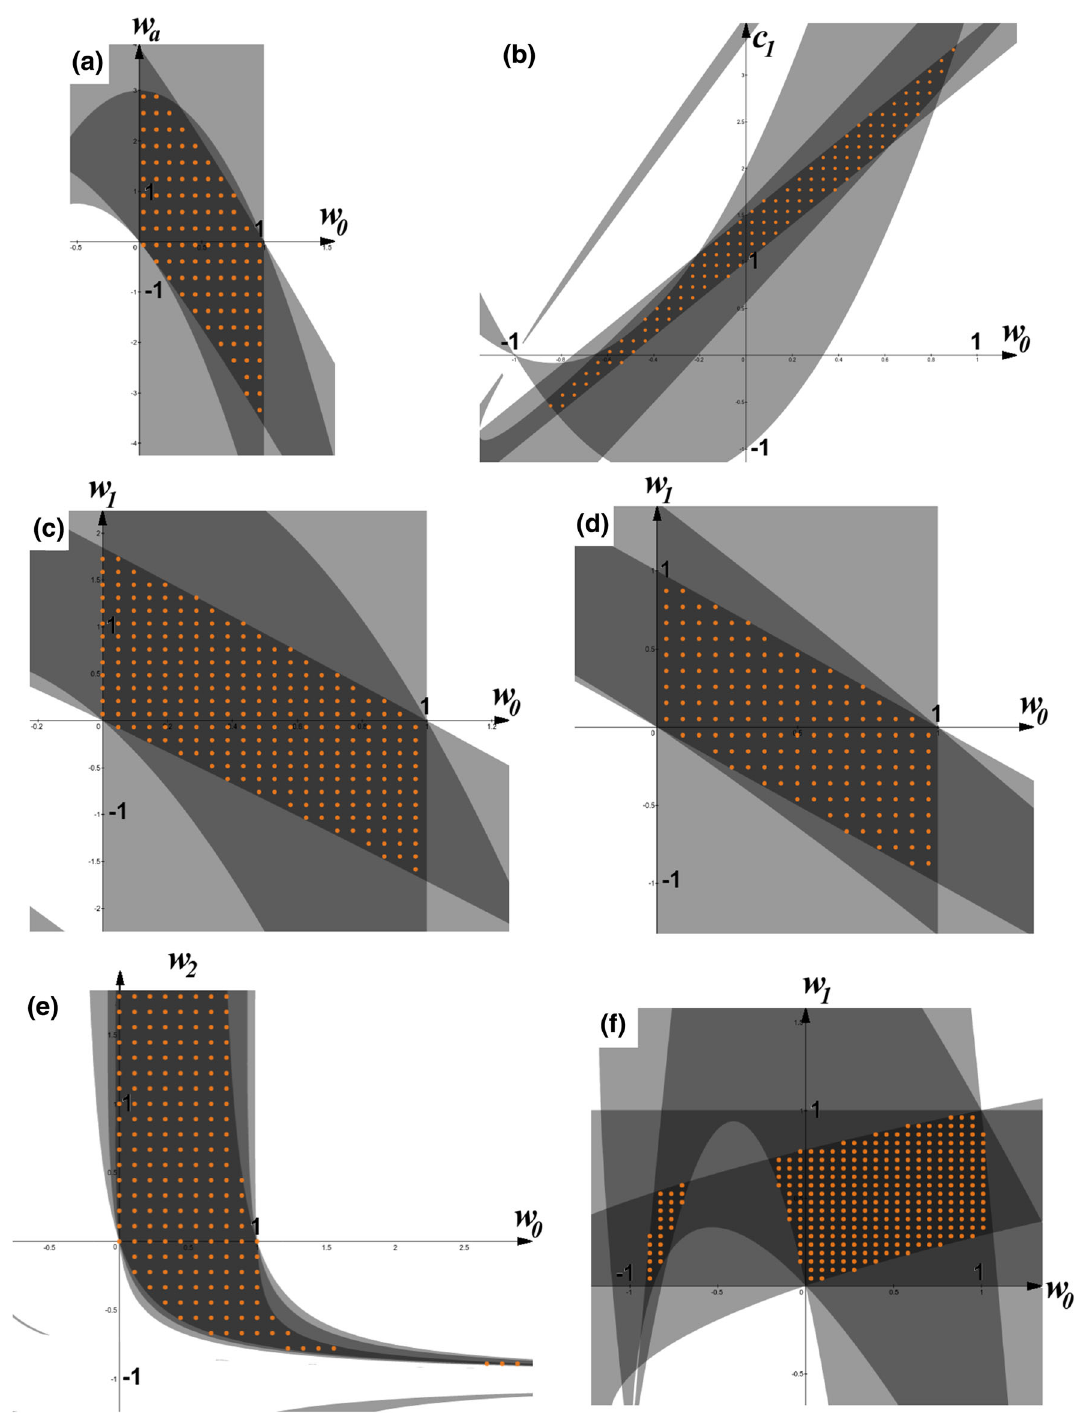
Fig. 2 The allowed parameter regions for two-parameter models [30] in plot ( a ), [32] in plot ( b ), [33] (model 1) in plot ( c ), [33] (model 2) in plot( d ),[36]inplot( e )andthree-parametermodel[27]for a ∗ = a 0 / 3in